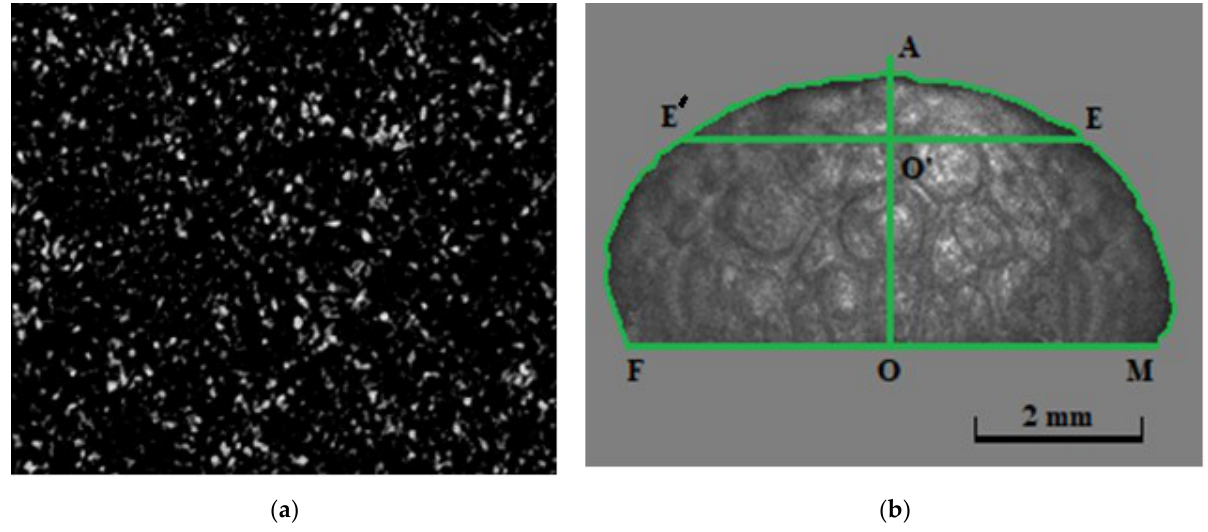
Figure 2. ( a ) An example of a snapshot of the dynamic speckle pattern obtained using the camera 1; the frame rate is 120 fps and the size of the image fragment is 330 × 250 pixels; ( b ) an example of the contoured image of the expanding foam.